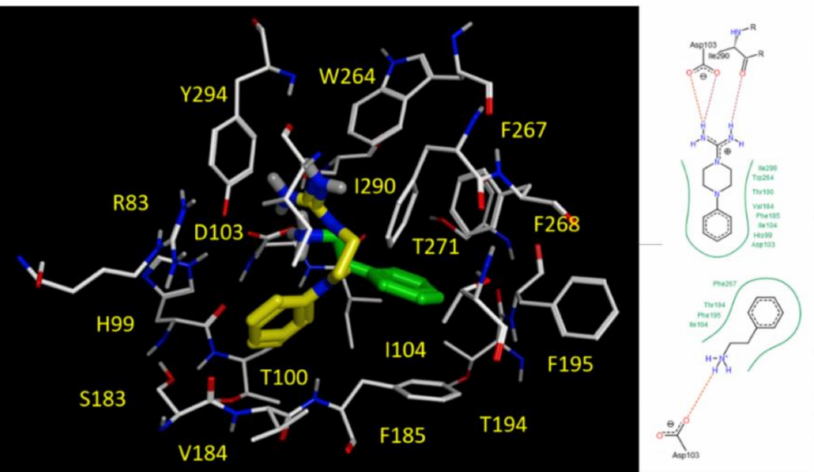
Figure 12. Docking positioning of the amidine-containing derivatives 1 ( C atom; yellow) and β -PEA ( C atom; green) as h TAAR1 agonists at the receptor crevice ( left ). Ligands are shown as sticks. The most relevant residues are labelled. A schematic perspective of the most relevant H-bonds experienced by the two agonists is also shown ( right ).